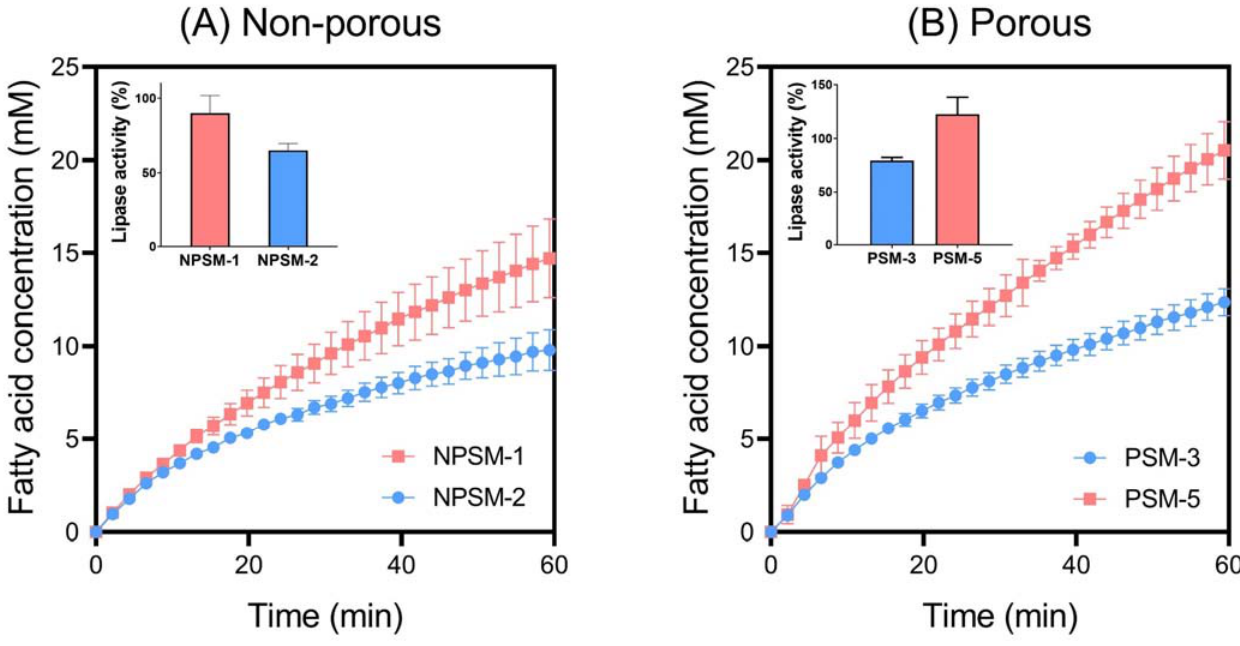
Figure 6. In vitro lipid digestion profiles highlighting the impact of particle size on lipolysis kinetics for ( A ) non ‐ porous silica microparticles and ( B ) porous silica microparticles. Insets: lipase activity as a function of particle size. In vitro digestion studies were performed under simulated fed state conditions, with data representing the digestion occuring during the intestinal phase (pH 6.0). Data represent mean ± S.D. ( n = 3).